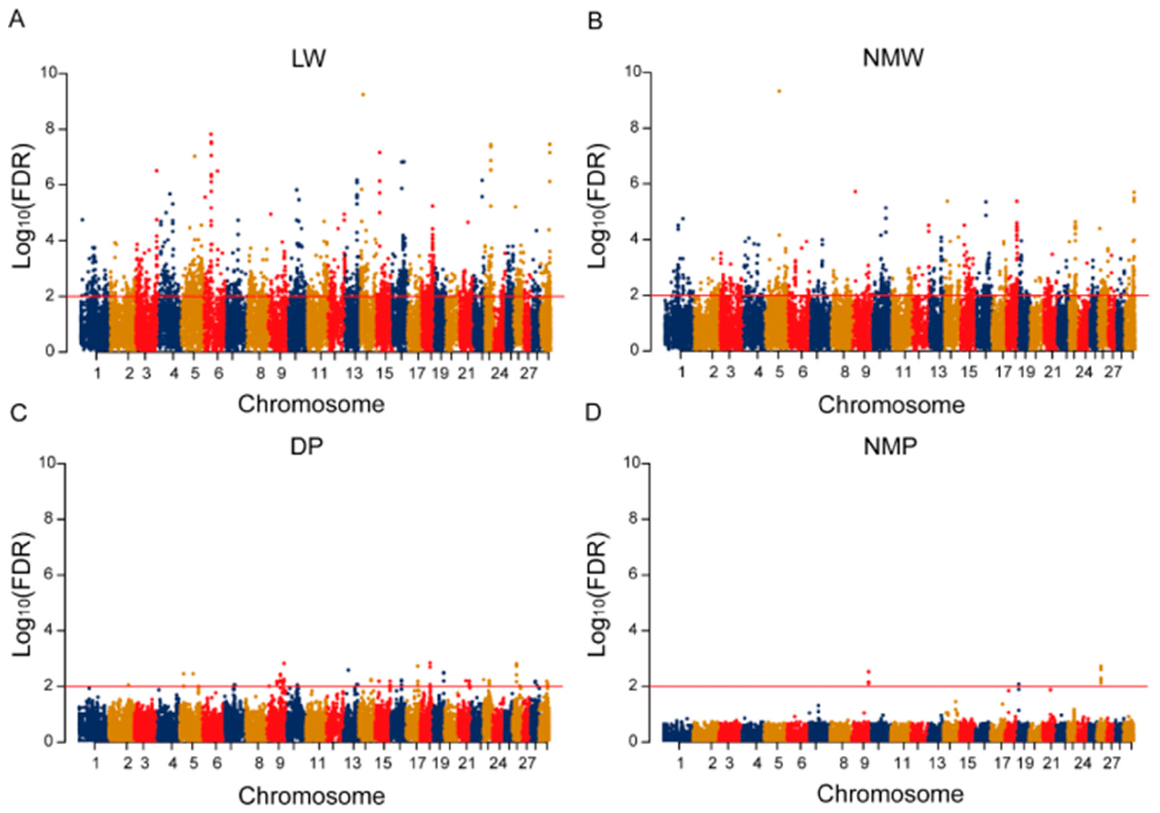
Figure 1. ( A – D ) The Manhattan plots of the gene-based GWAS results for live weight (LW), net meat weight (NMW), dressing percentage (DP) and net meat percentage (NMP). Chromosomes are shown in different colors.